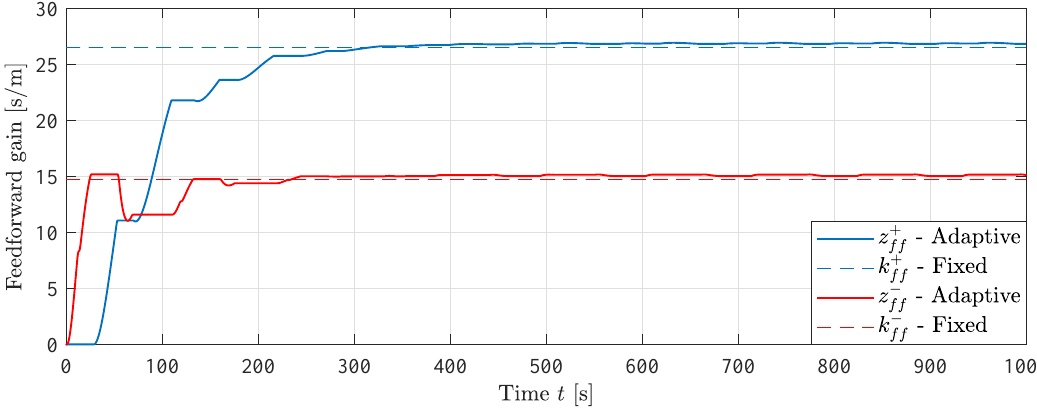
Figure 17. Feedforward states during MIT-rule feedforward simulation, γ = 200 s · m − 3